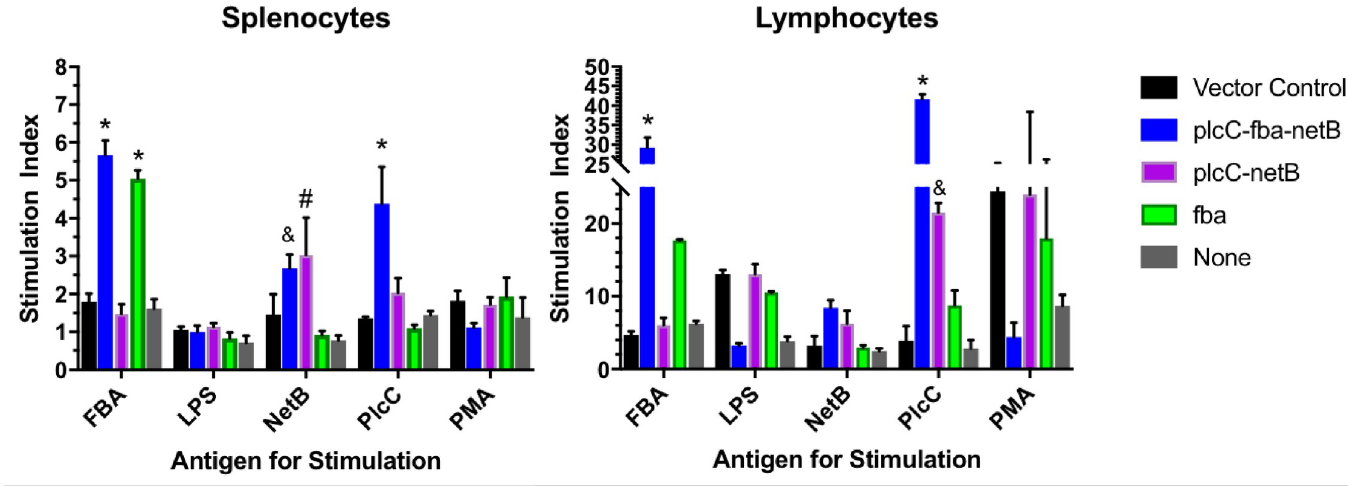
Fig 4. Cellular responses by splenocytes and lymphocytes from vaccinated and non-vaccinated chickens. Significant differences compared to controls are indicated. � , P < 0.0001; # , P < 0.005, & , P <